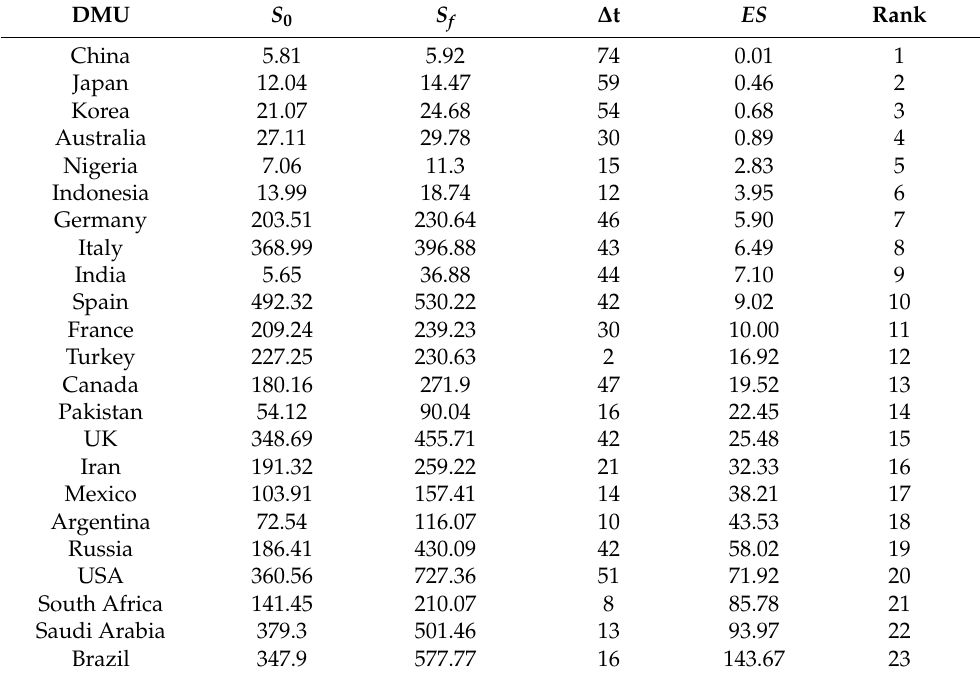
Table 4. The epidemic stability for each country by